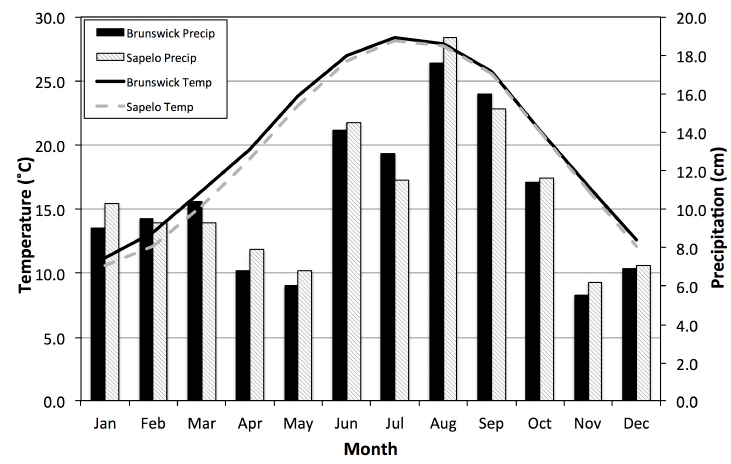
Figure 2. Monthly mean temperature and precipitation (1981–2010) for Brunswick and Sapelo Island, Georgia.